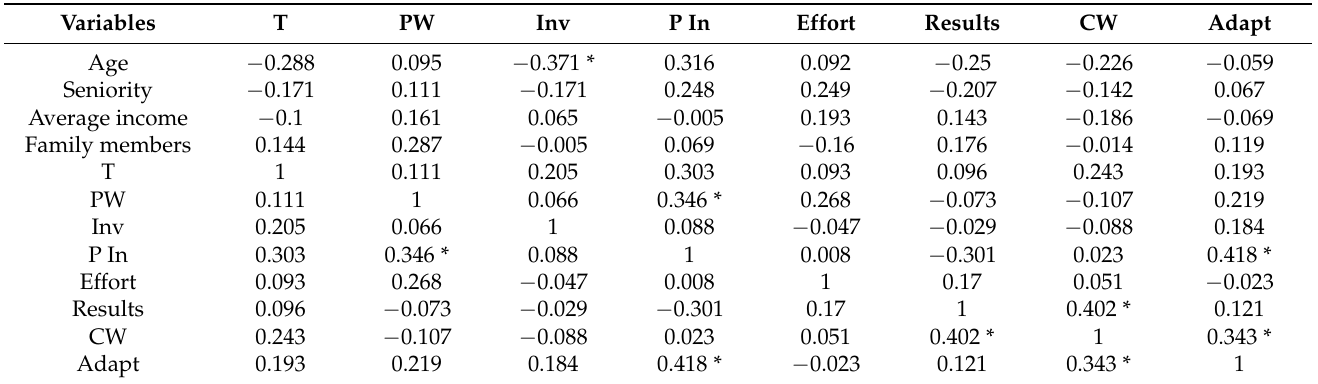
Table 10. Correlations between various variables associated with the group of teachers.